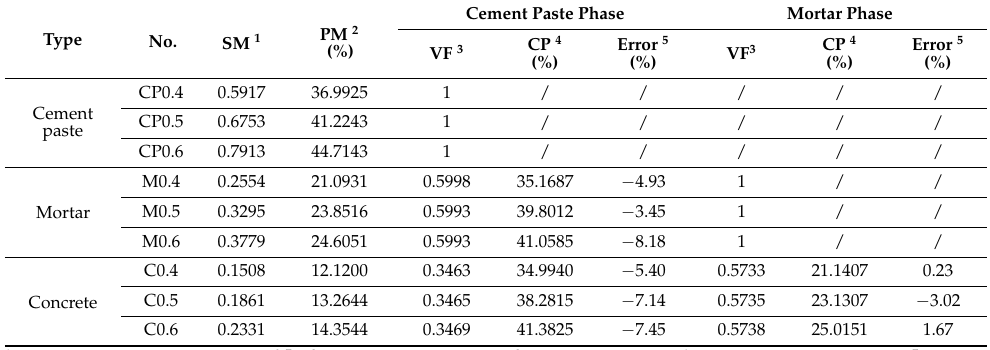
Table 2. Mean porosities and sorptivities, and the calculated porosities of the undamaged speci- mens.